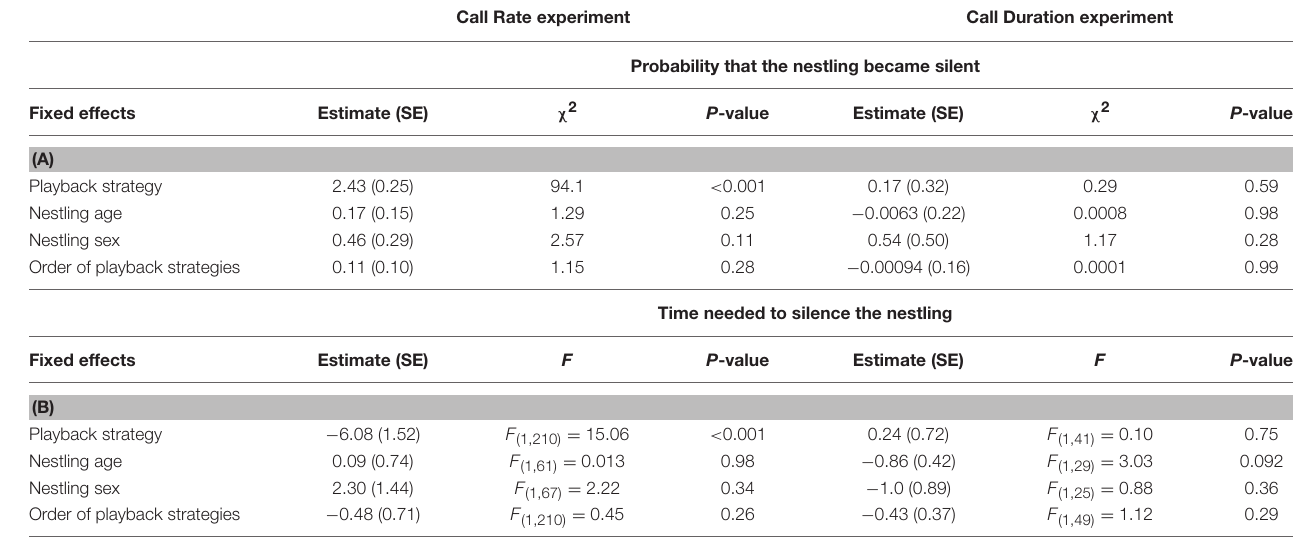
TABLE 2 | Effect of playback strategies on the probability that nestlings became silent (A) and on the time needed to silence nestlings (B) . Call Rate experiment Call Duration experiment